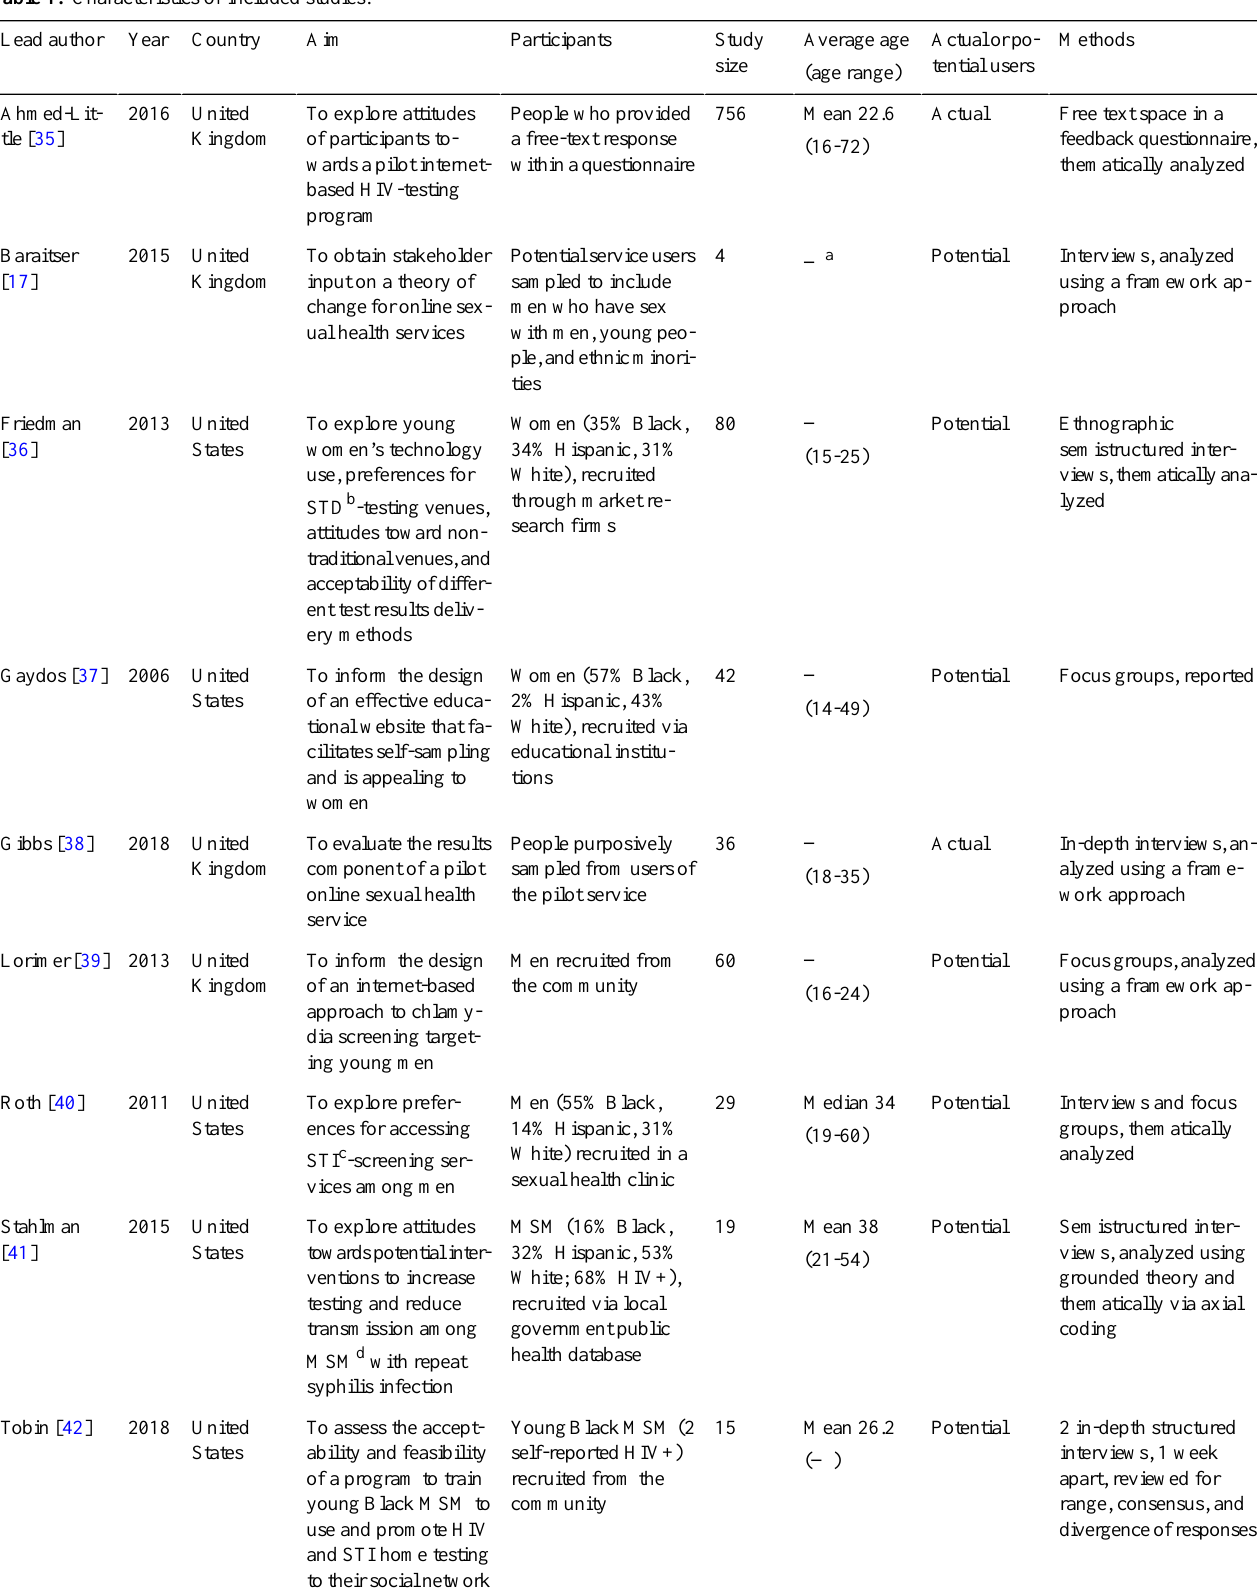
Table 1. Characteristics of included studies.